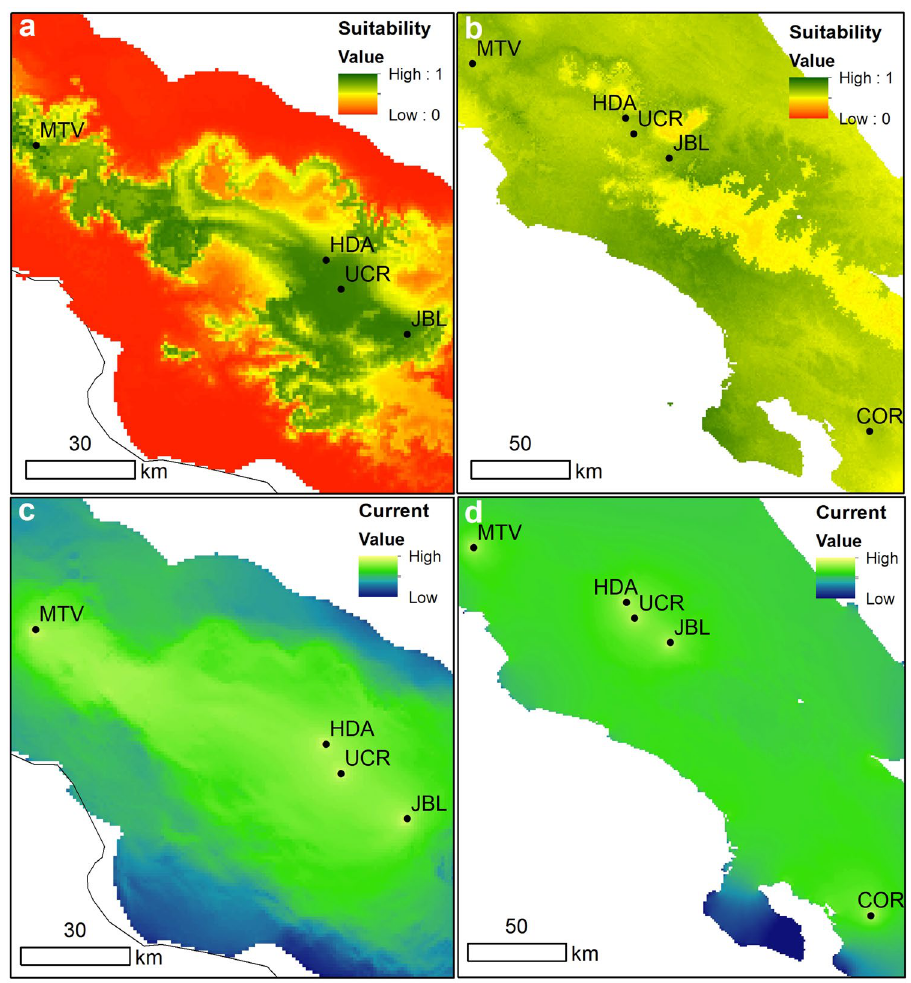
Figure 5. Maps of ( a , b ) habitat climatic suitability using MAXENT with clog-log transformation for ( a ) . white-eared ground-sparrow ( Melozone leucotis ) and ( b ) house wren ( Troglodytes aedon ) in Costa Rica. ( c , d ) Represents maps of cumulative current within sampling site, modelled with circuit theory algorithm using Circuitscape 4.0, based on MAXENT climatic suitability prediction for ( c ) white-eared ground-sparrow sampling sites and ( d ) house wren sampling sites . MTV Monteverde, HDA Heredia, UCR University of Costa Rica, JBL Lankester Botanical Garden, COR